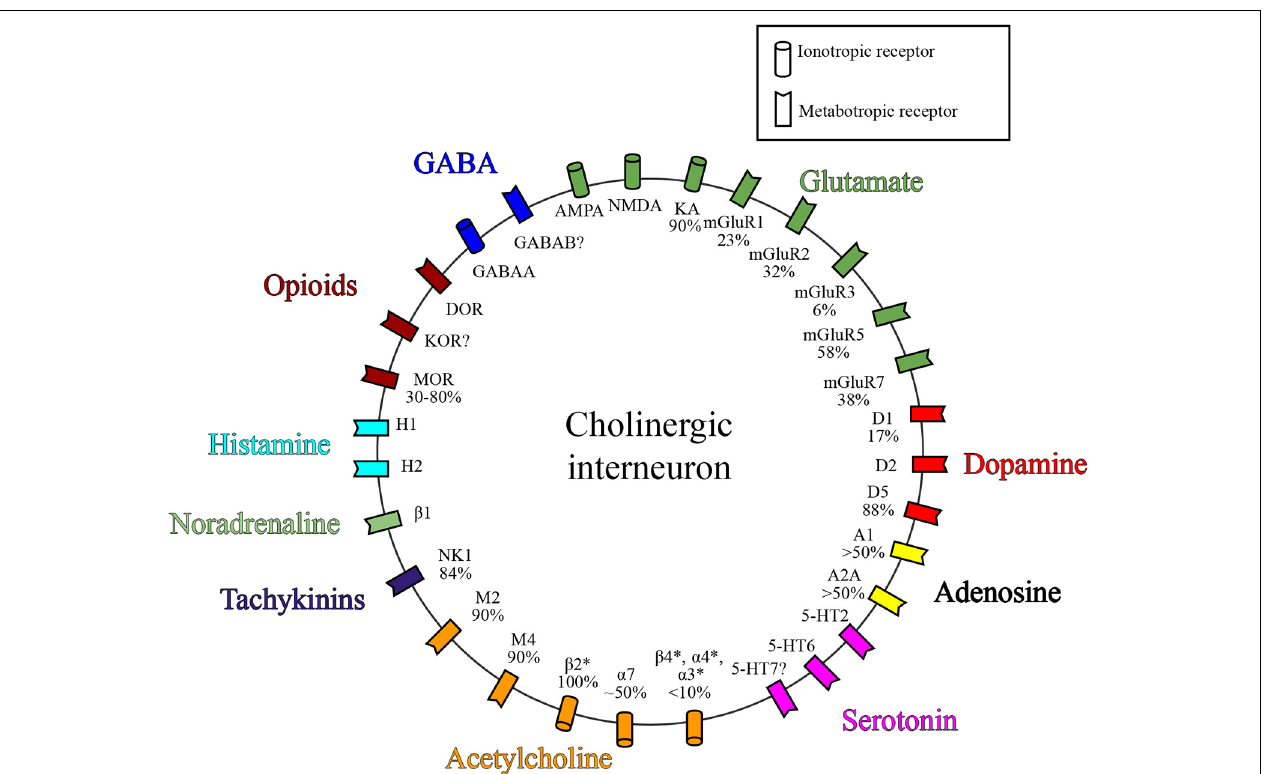
FIGURE 2 | Receptor expression on ChIs. Simplified diagram depicting a subset of known receptor classes expressed on ChIs grouped by neurotransmitter. Values represent percent of ChIs that express the given receptor. References for receptor expression by ChIs can be found in the text and Table 2